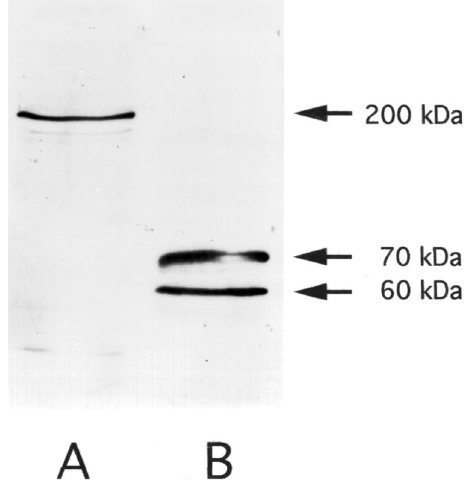
Fig. 3. Western blotting analysis of AS-2 antibody against cytoplasms and nuclei. Cytoplasmic extracts (lane A) and nuclear extracts (lane B) from exponentially growing K562. Molecular weight standards (range 29–205 kDa) were run in parallel. A 200 kDa band in the cytoplasms and two bands of 70 and 60 kDa in the nuclei extracts were found as indicated by arrows. Reproducibility of these data was repeatedly